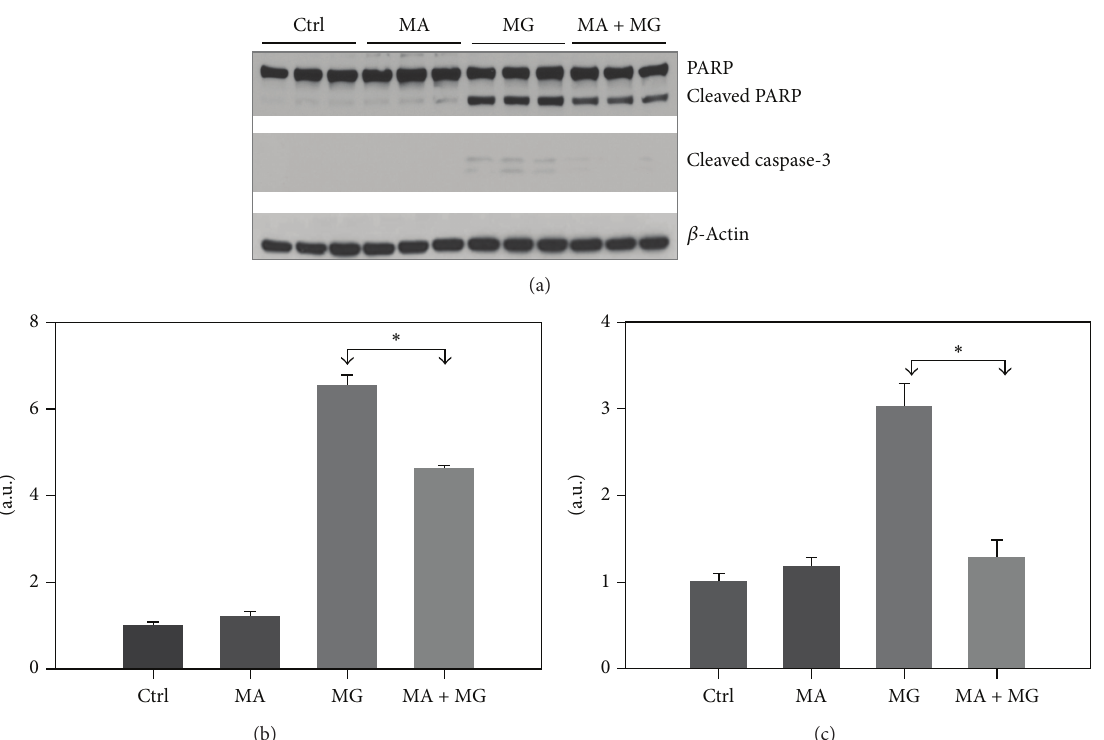
Figure6:Theautophagyinhibitor3-methyladenine(3-MA)attenuatesMG132inducedPARPandcaspase3cleavage.Thecellswerepretreated with 3-MA (1mM) for 1h and then treated with MG132 for 24 h. (a) Western blot analysis for PARP, cleaved PARP, and cleaved caspase 3. Densitometric analysis for cleaved PARP (b) and cleaved caspase (c) from three independent experiments. Level of significance is denoted as ∗ 𝑝 ≤ 0.01